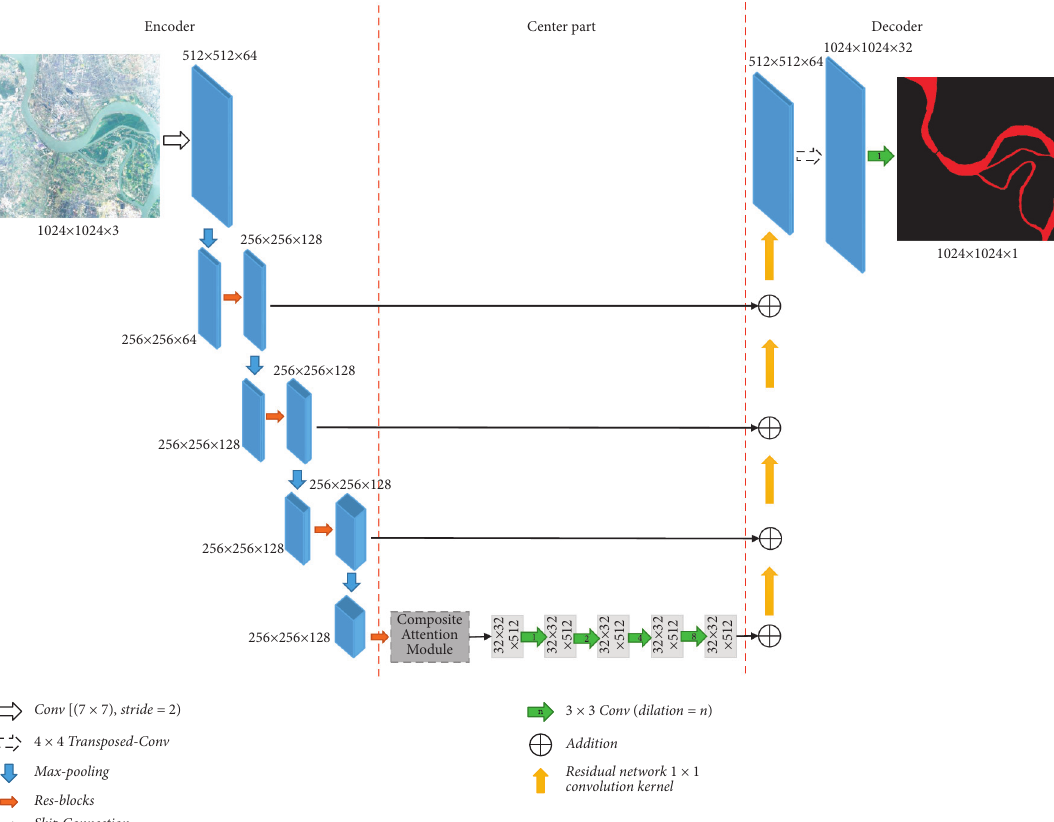
Figure 2: Composite attention network for river